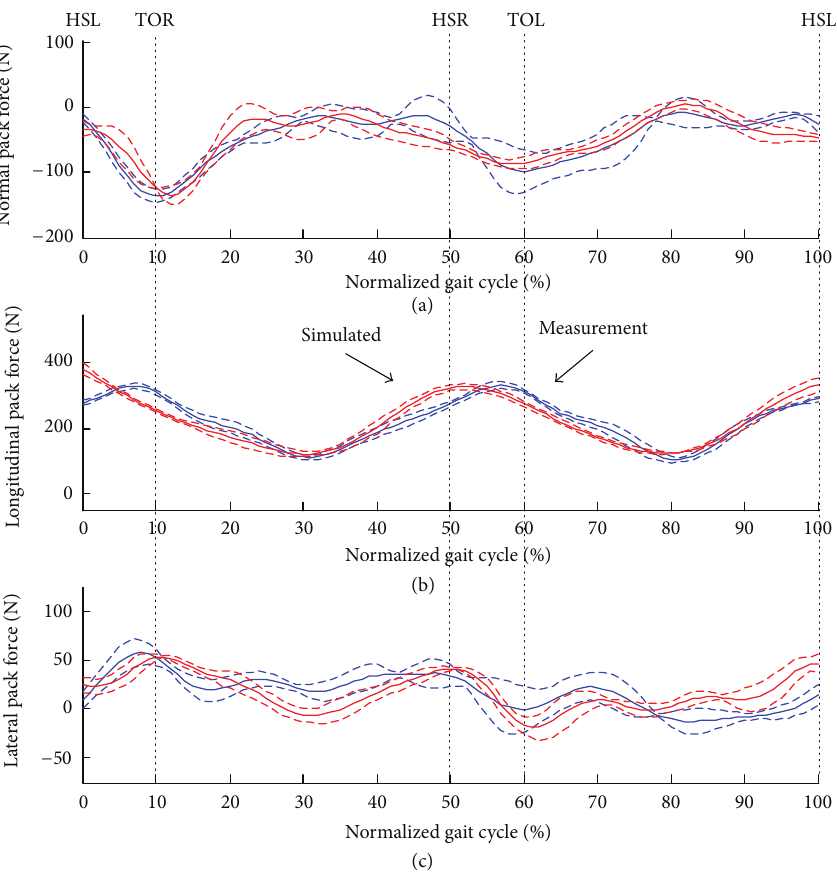
Figure 11: The simulated pack interaction forces in the pack coordinate system (mean (solid red line) ± one standard deviation (dashed red lines)): (a) longitudinal pack force, (b) normal pack force (c), and lateral pack force, compared with measured data (mean (solid blue line) ± one standard deviation (dashed blue lines)), for six repeated trials for one subject (age: 28yrs, weight: 71.8kg, height: 178 cm). The average walking speed was 1.62 ± 0.04 m/s, and the pack load was 23.0 kg. The stance phase for the left limb is from 0 to 60.3%, and the swing phase is from 60.3% to 100%. The double support phase is from 0 to 10.3% and from 50 to